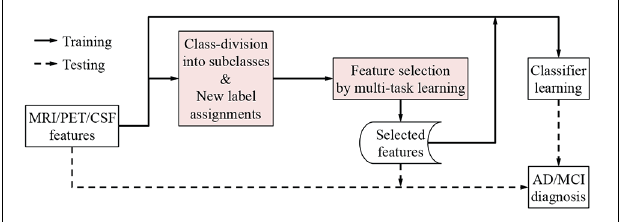
FIGURE 2 | A framework for AD/MCI diagnosis with the proposed subclass-based multi-task